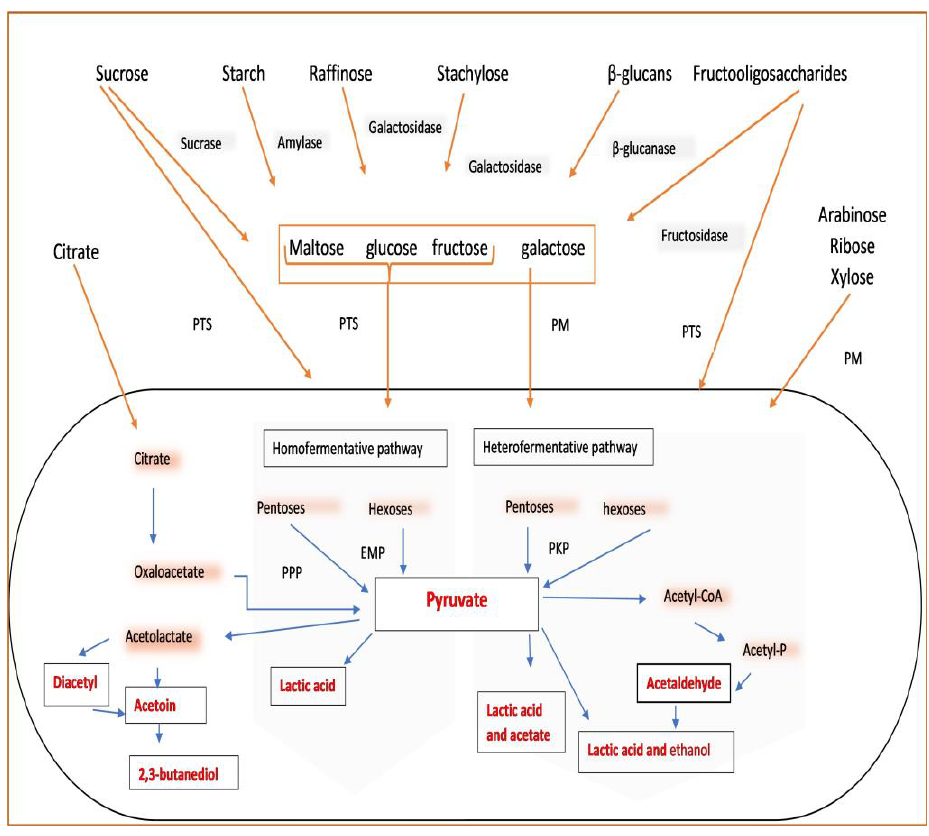
Figure 1. LAB carbohydrate and organic acid metabolism and flavour compounds produced. Phosphotransferase system (PTS), permease (PM), pentose phosphate pathway (PPP), Embden–Meyerhof pathway (EMP), phosphoketolase pathway (PKP). Flavour compounds labelled in red. Table 2. Organoleptic properties of aroma and flavour metabolites identified in African fermented